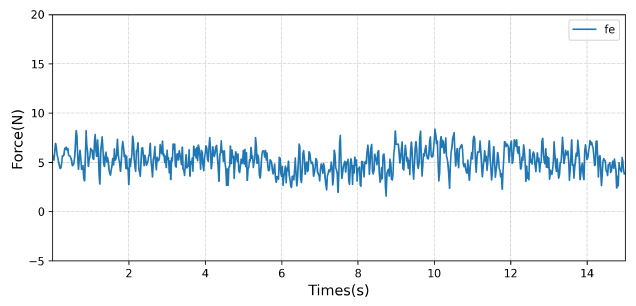
Figure 12. Real experimental